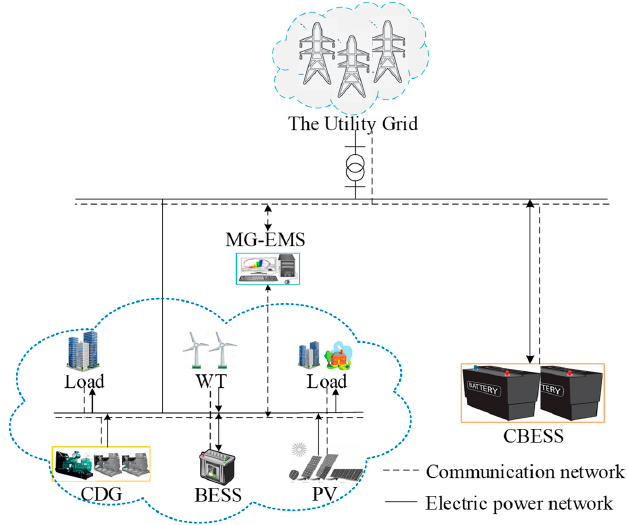
Figure 1. Test system configuration.